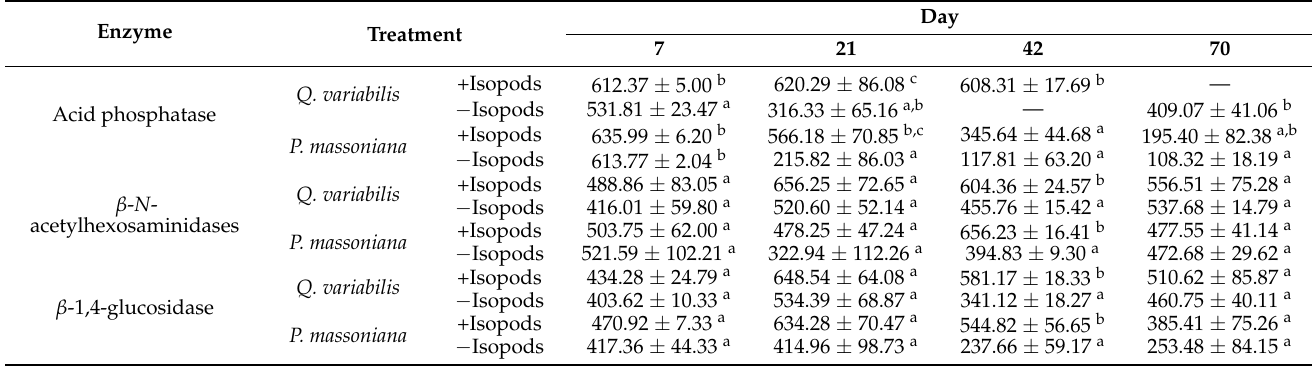
+Isopods: with isopods; − Isopods: without isopods. Data with different superscript letters in a transverse row are Table 2. Enzyme activity measured by zymography at 7 days, 21 days, 42 days and 70 days in the significantly different ( p < 0.05, n = grazing area (pmol·cm − 2 ·h − 1 ).